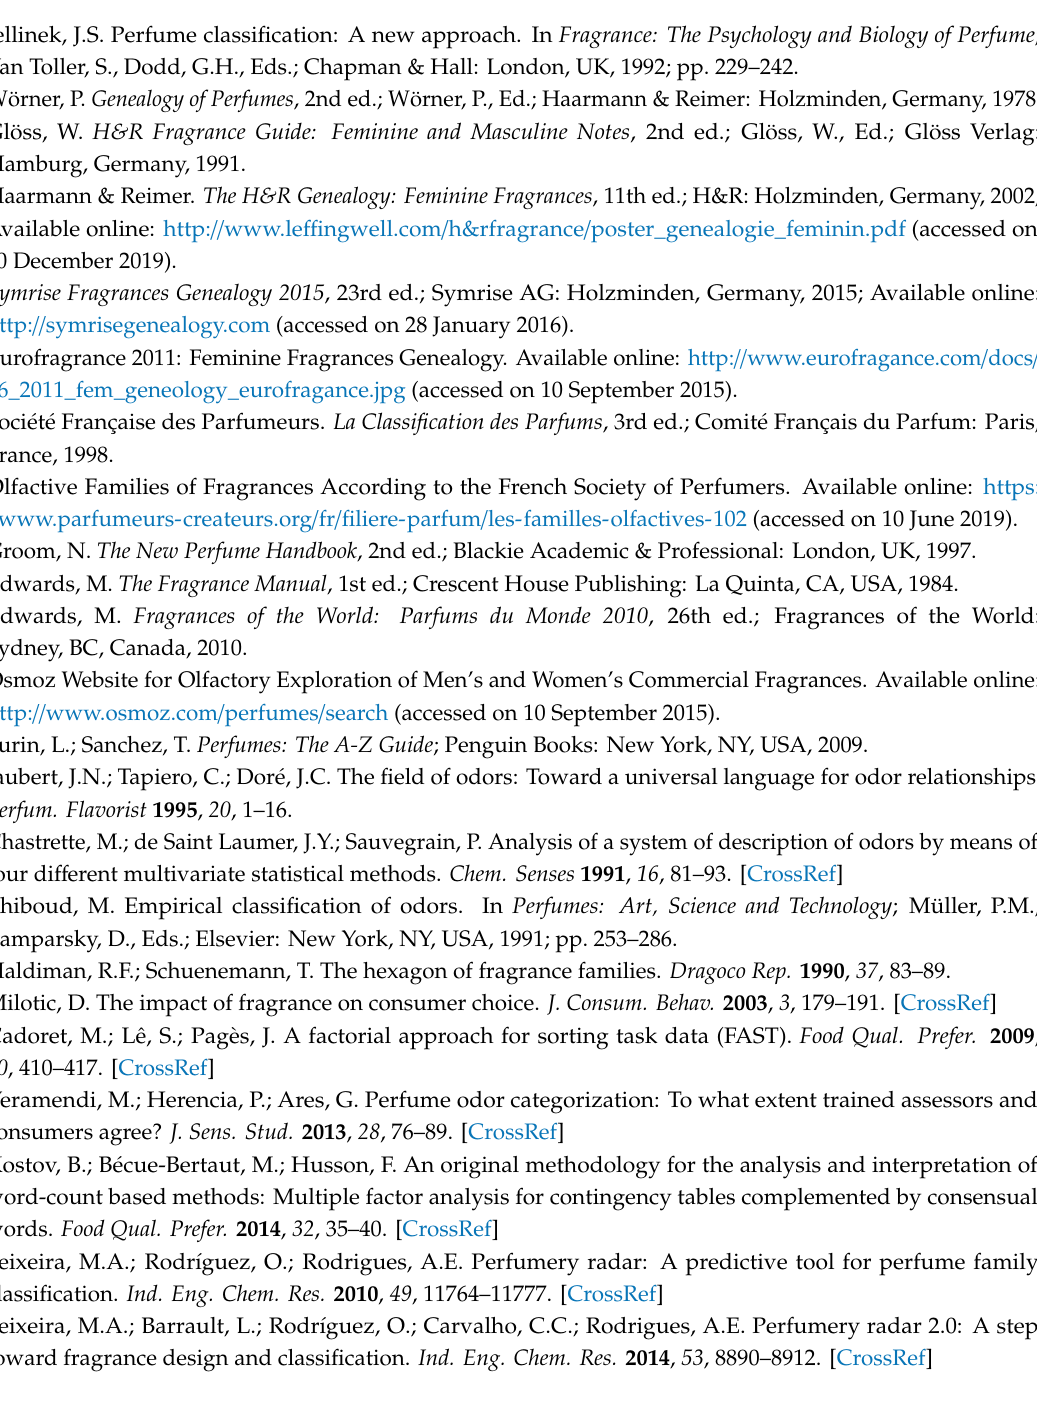
Figure S1: Loading plot of the PCA applied to olfactory profiles from Fragrantica’s website and the H&R guide for the 176